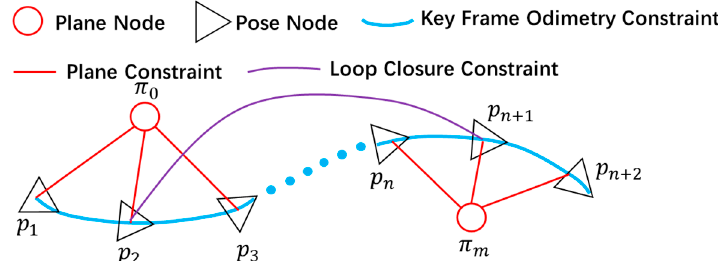
Figure 6. Schematic diagram of the pose structure SLAM, π ...π { π } is the extracted roadway ground plane coe ffi cient node. n 0 , 1 ,